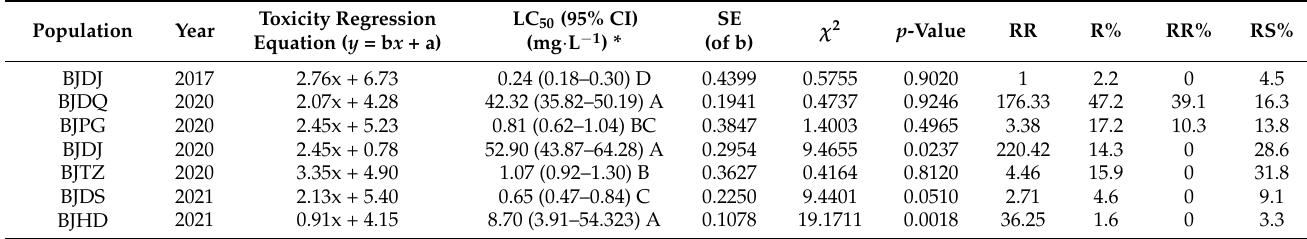
Table 1. Regressions for spinetoram responses and frequencies of G275E R/S genotypes in seven Frankliniella occidentalis